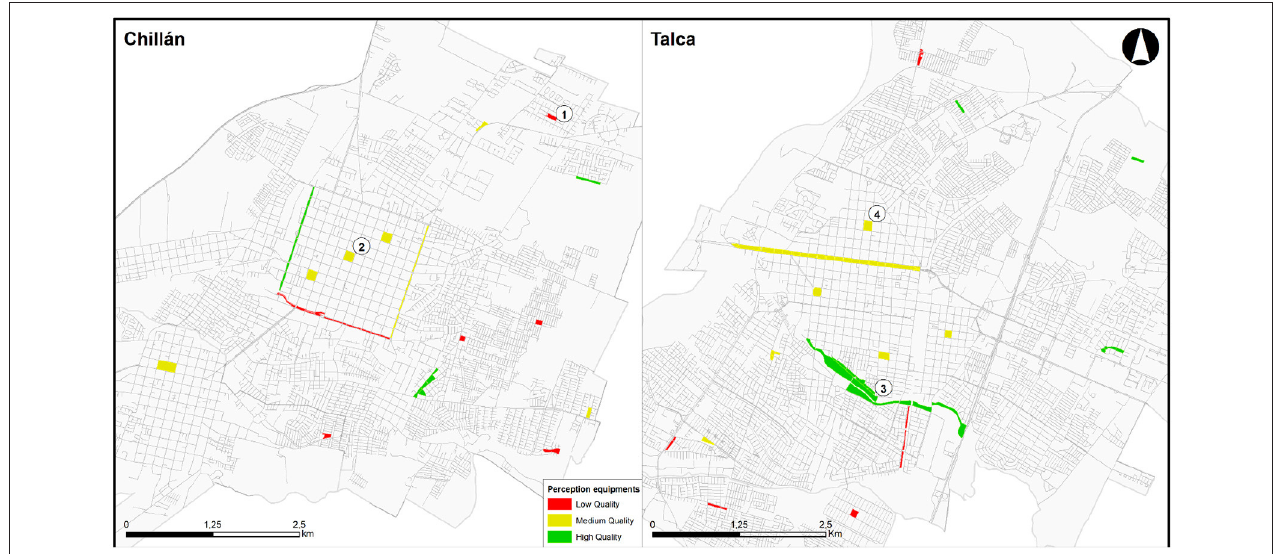
FIGURE 8 | The 33 green spaces that were evaluated by survey participants, colored by perception.